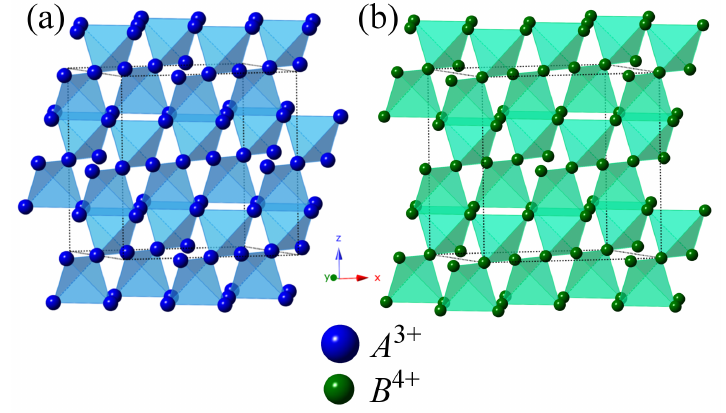
Figure 1. Three-dimensional network of corner-sharing tetrahedra of the A ( a ) and B site ( b ) sublattices of the pyrochlore